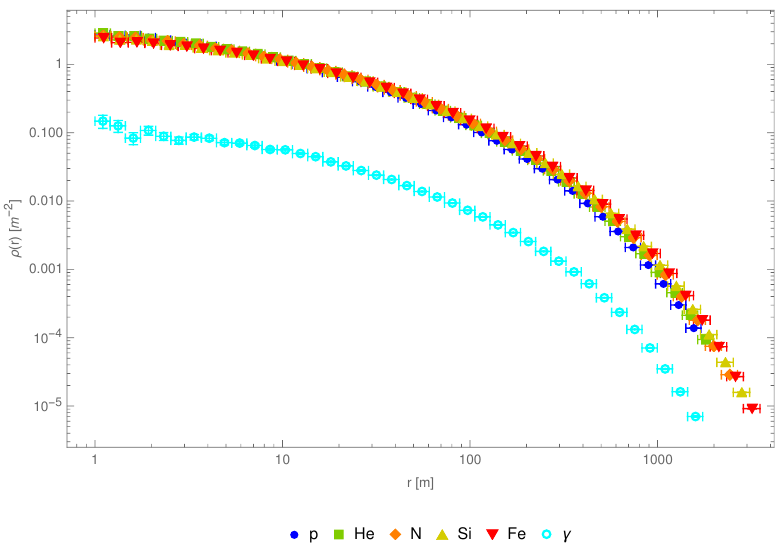
Figure 6. ρ ( r ) distribution of muons in cascades initiated by different primary cosmic-ray particles with energy E = 4000 TeV.